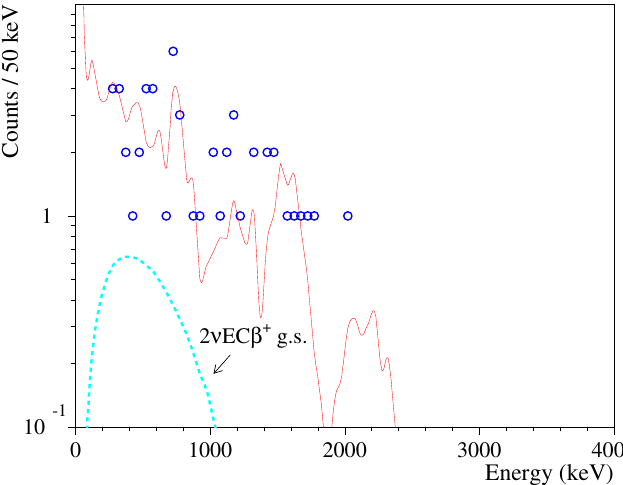
Figure 10. Energy spectrum of γ and β events measured by the 106 CdWO 4 detector for 26,033 h in coincidence with 511 keV annihilation γ quanta in both of the CdWO 4 counters (circles). The expected background, which was built on the basis of the fit presented in Figure 7, is shown by a red solid line. The excluded distribution of the 2 ν EC β + decay of 106 Cd to the ground state of 106 Pd with the half-life T 1/2 = 2.1 × 10 21 yr is